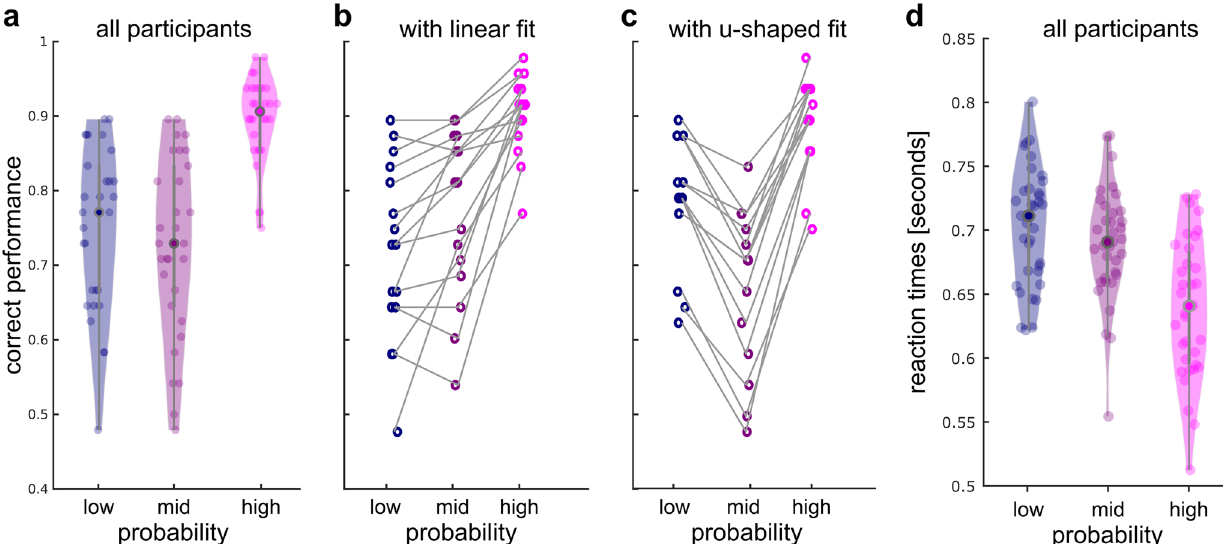
Fig. 2 Behavioral results. a Correct performance in the face task. Participants learned to associate scene cues and face images with their corresponding probability. Participants could be split into two groups, based on whether their response pro fi les followed a linear (in b ) or u-shaped fi t (in c ). This indicates that they might have used different strategies to anticipate the faces. d Reaction times in the face task. Participants responded faster to faces that were expected with high probability than to those expected with a low